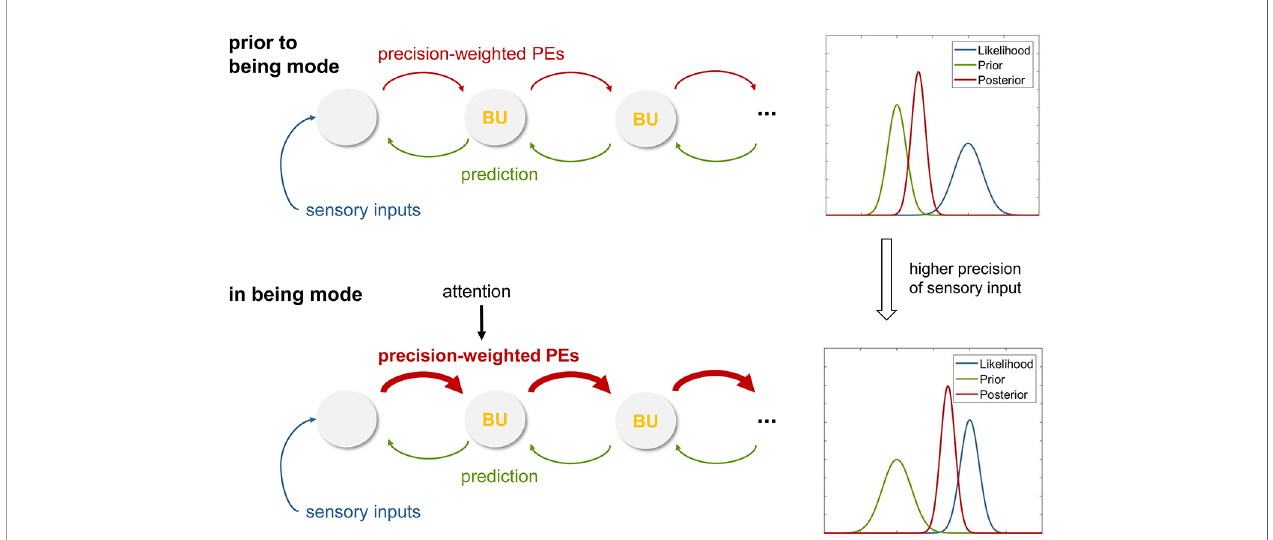
FIGURE 6 | (A) Graphical summary of predictive coding that illustrates the exchange of prediction errors and predictions (prior beliefs) across levels of a cortical hierarchy. In this schematic of predictive coding, perception corresponds to Bayesian belief updates (BU) across the hierarchy. This panel represents the case before an individual adopts the being mode, with perception strongly shaped by priors (as illustrated on the right). (B) This panel illustrates a hypothetical mechanism for instantiating the being mode. Speci fi cally, attentional modulation of forward connections in the cortical hierarchy is proposed to induce higher sensory precision and thus enhanced precision-weighting of prediction errors (PE), leading to rapid belief updates that are closely coupled to the sensory inputs. This corresponds to a perceptual style that lacks “ bias ” (as usually imposed by the brain ’ s internal model; compare panel A) and is closely synchronized to sensations. See main text for